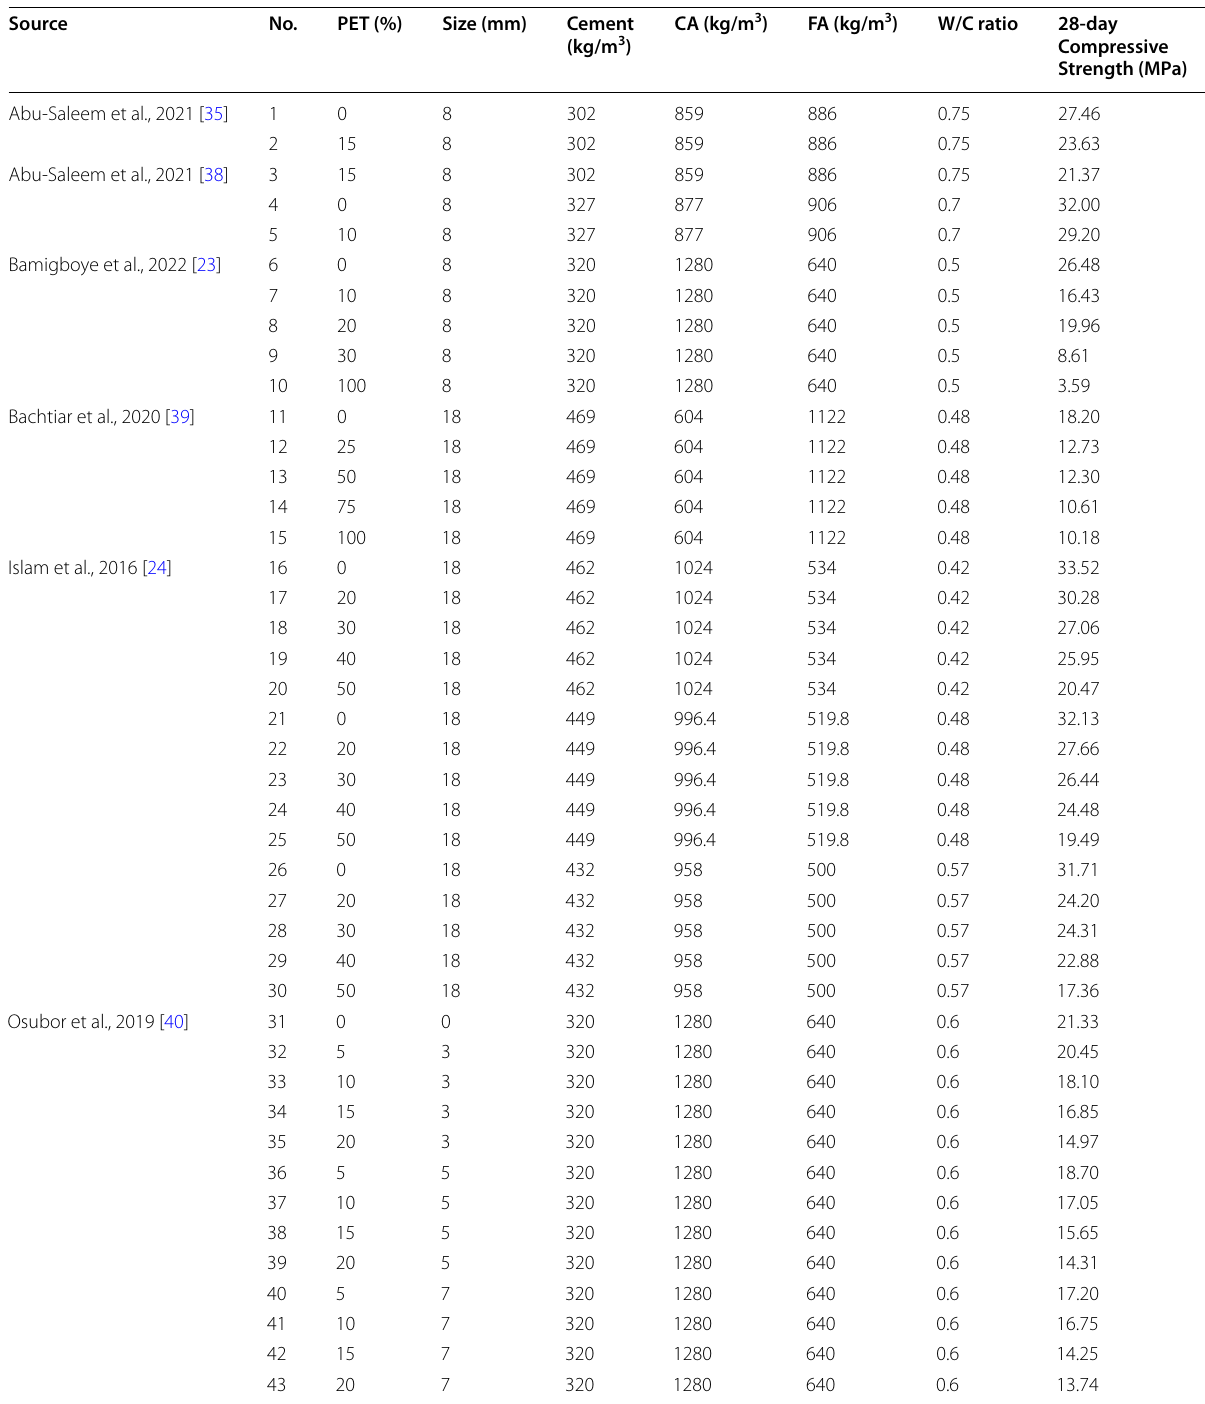
Table 1 Literature for PET-CA expression